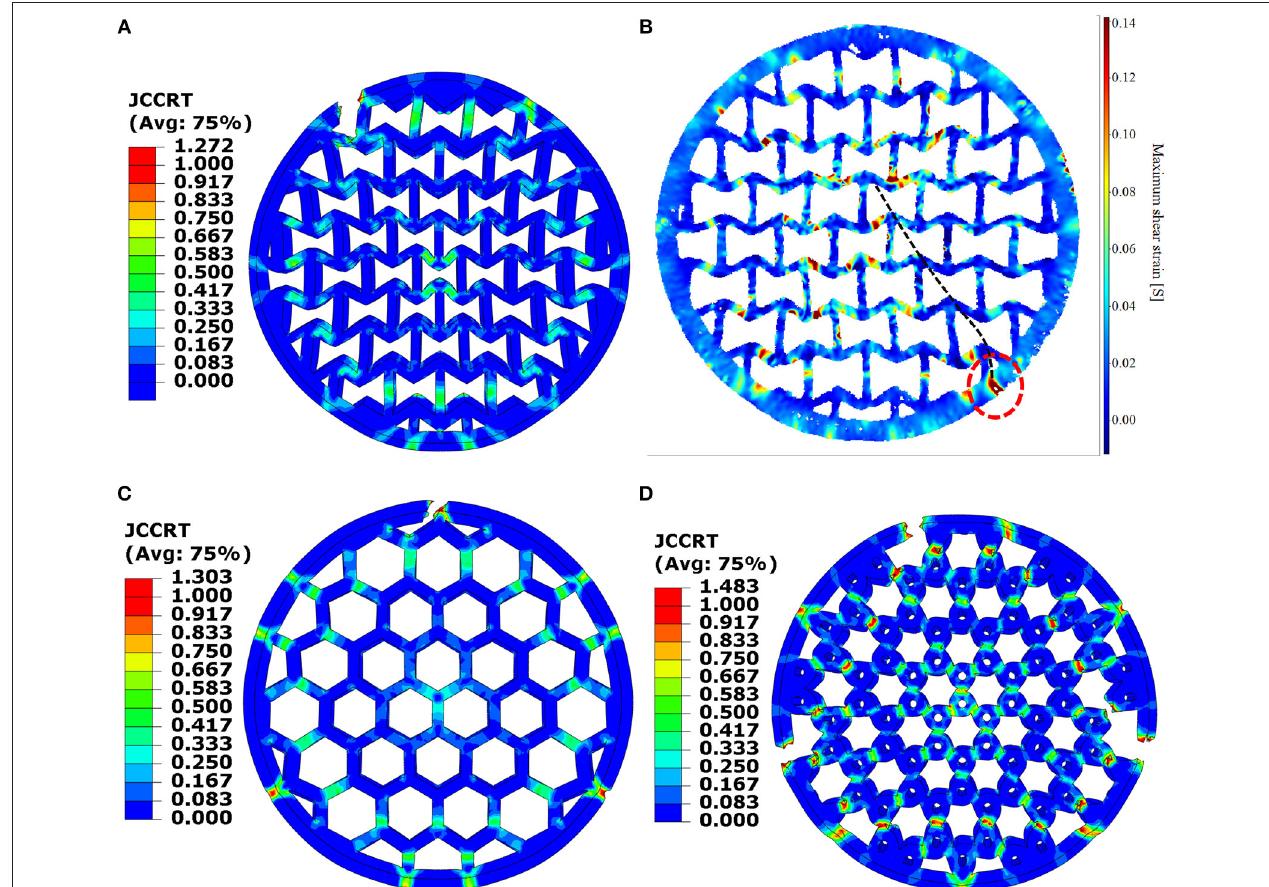
FIGURE 13 | FE vs. DIC fracture initiation, showing: (A) FE re-entrant, (B) DIC re-entrant, (C) hexagonal, and (D) tri-chiral topologies. FE data is the value for the JC fracture criterion. DIC data is the maximum shear strain.